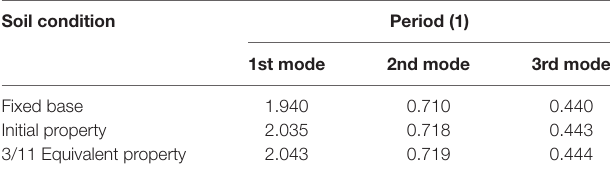
TaBle 4 | Results of eigenvalue analysis (N–S